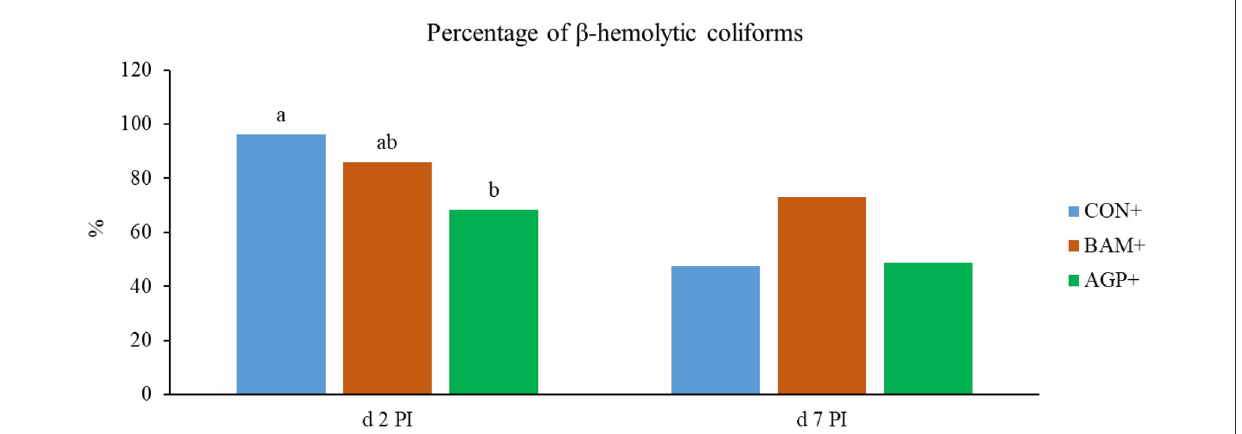
FIGURE3 The percentage (%) of β -hemolytic total coliforms in fecal samples of Escherichia coli challenged weaned pigs fed a control diet (CON + ) or diets supplemented with Bacillus amyloliquefaciens (BAM + ) or antibiotics (AGP + ). No β -hemolytic coliforms were observed in the fecal samples of pigs in the sham groups. No β -hemolytic coliforms were observed in the fecal samples of pigs before E. coli (ETEC) challenge and on days 14 and 21 post-inoculation (PI). Each least squares mean represents 9–10 observations. a,b Means without a common superscript are different ( P <